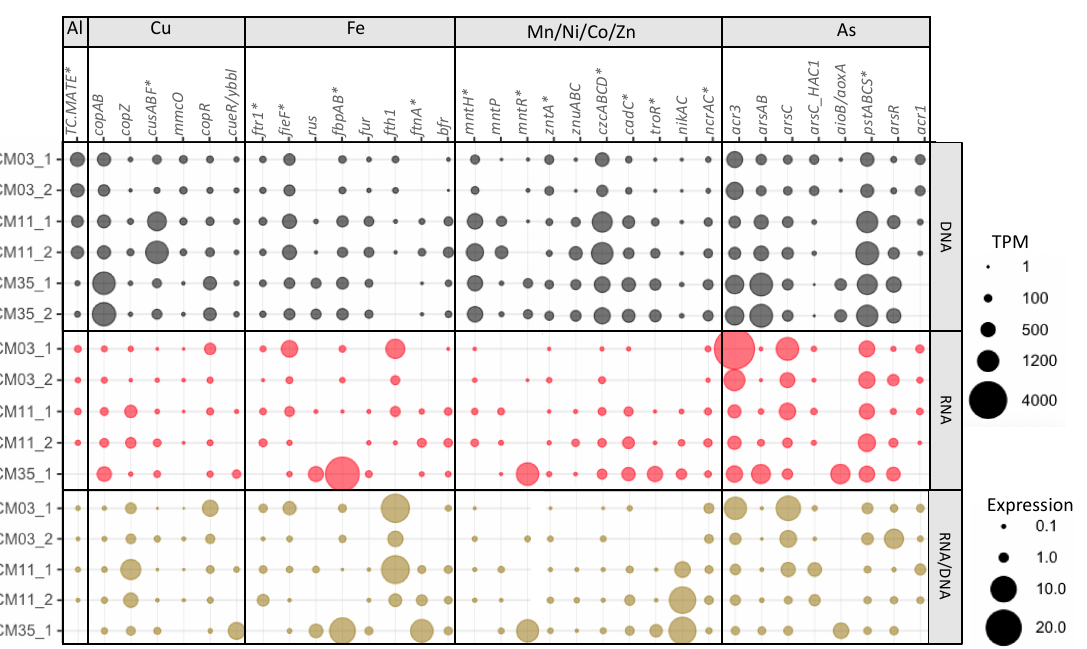
Figure 3. Normalized gene abundance (upper rows), normalized transcript abundance (middle row), and expression (lower rows) of metal-specific metal resistance genes (except with *) detected in the three layers of Cueva de la Mora (CM). Normalized gene and transcript abundances are calculated as TPM values. Expression is calculated as transcript TPM / gene TPM. 1 and 2 refer to replicates (DNA or mRNA reads from each replicate mapped to co-assembled metagenomes). Gene functions and their respective KOs are listed in Table 3. mRNA reads from CM35_2 are not included due to low mapping rates to the co-assembled metagenome.